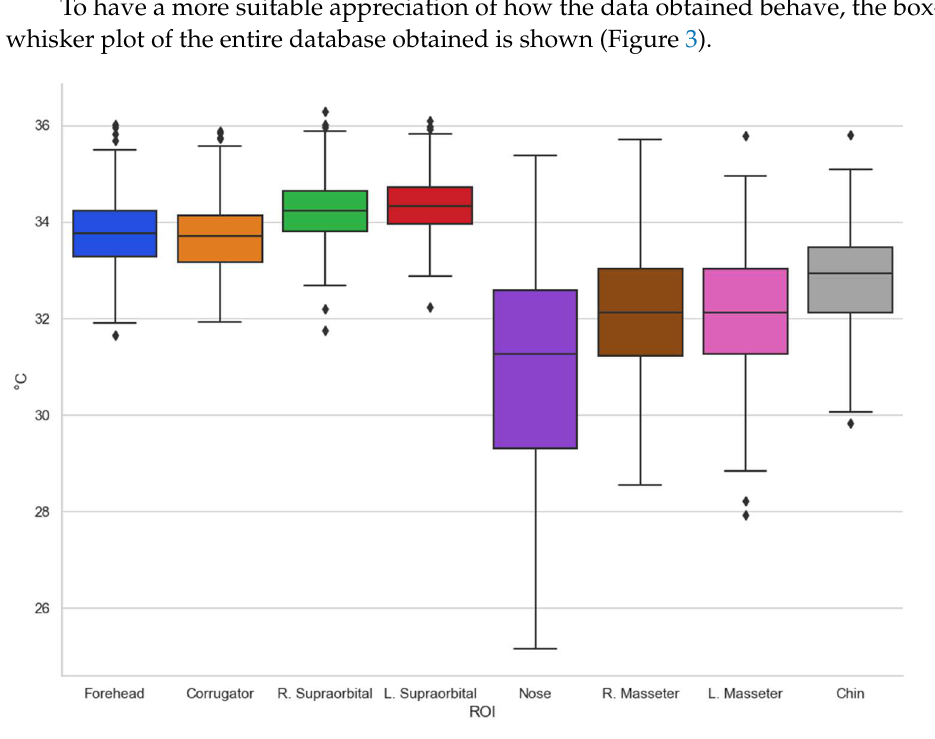
Figure 3. Box-and-whisker chart